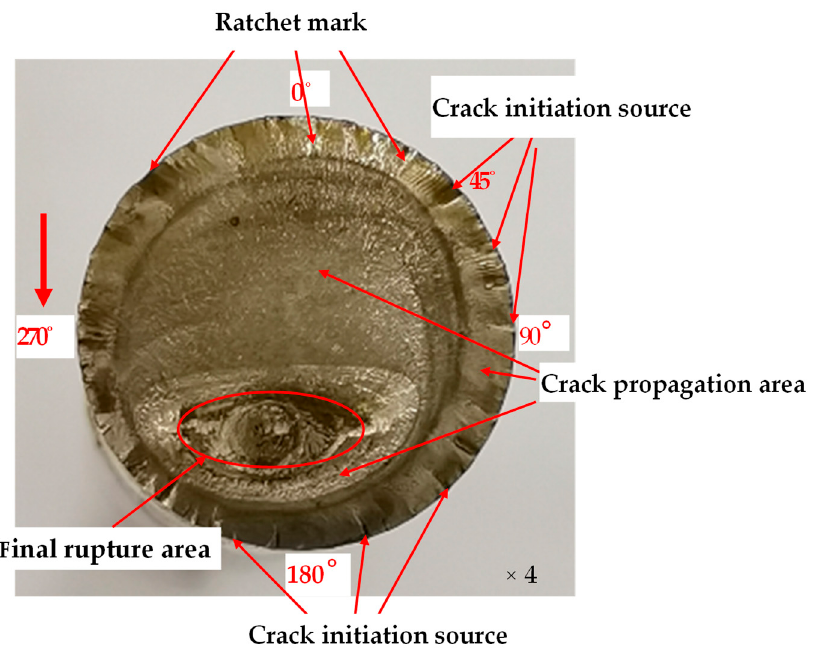
Figure 3. Schematic diagram of fatigue fracture.